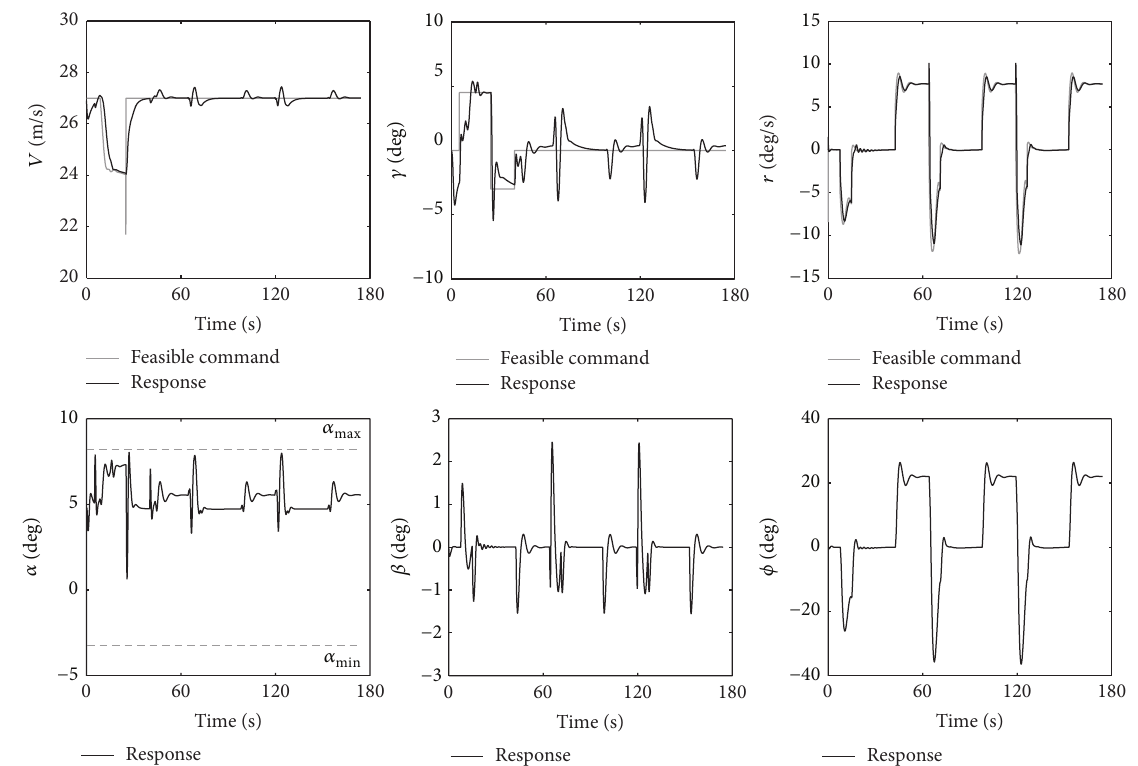
Figure 7: Controlled outputs and state variables in the simulation with reduced power and stability.